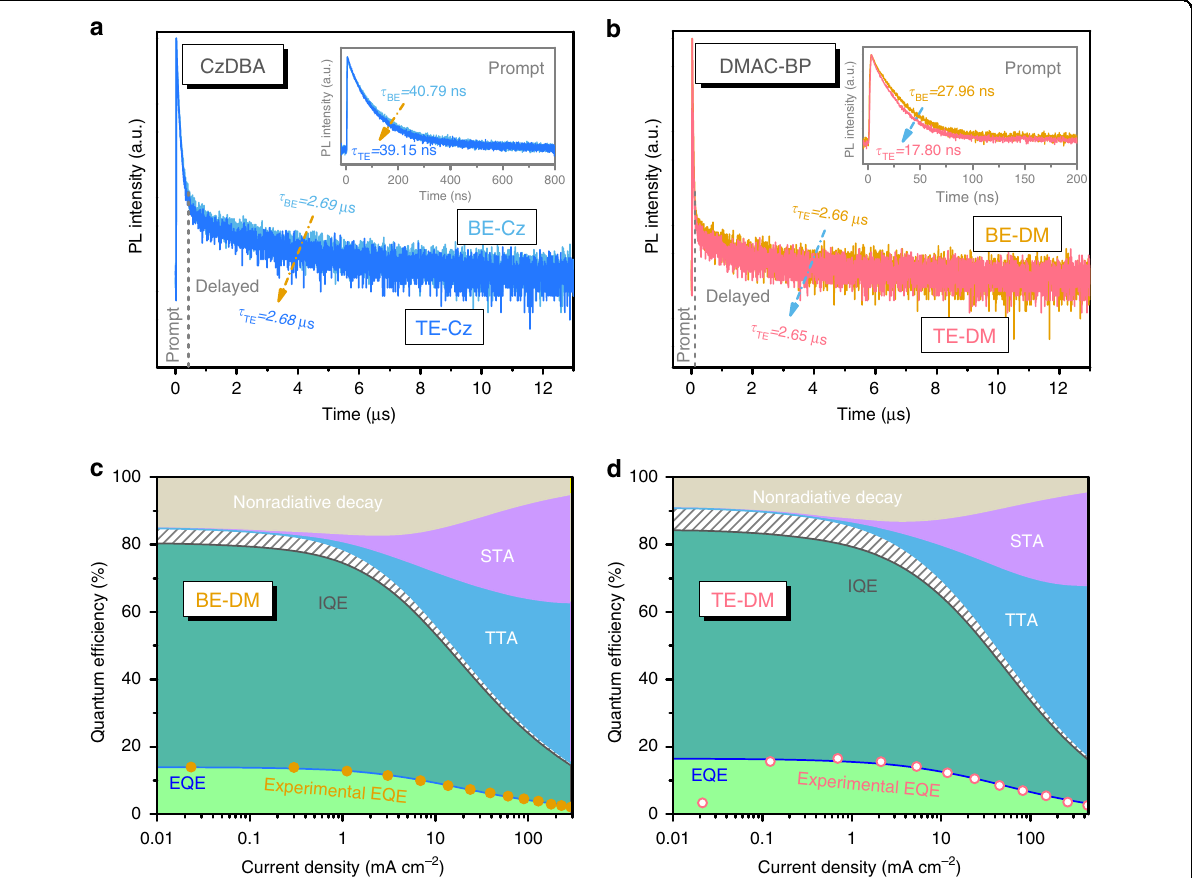
Fig. 4 Purcell effect for TADF emitters with different horizontal orientations in weak microcavities. Transient PL decay characteristics of a the CzDBA in the devices TE-Cz and BE-Cz and b the DMAC-BP in the devices TE-DM and BE-DM. Theoretically calculated IQE, EQE, and EQE loss due to nonradiative decay, TTA and STA, c for device BE-DM and d for device TE-DM. Areas fi lled with stripes in c and d correspond to the EQE loss caused by the γ